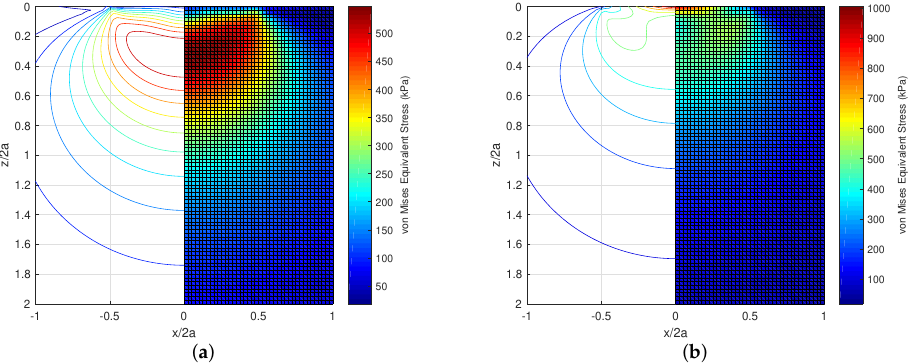
Figure 17. von Mises equivalent stress σ v in the xz -plane beneath loading cases ( a ) N4-T0 (frictionless) and ( b )